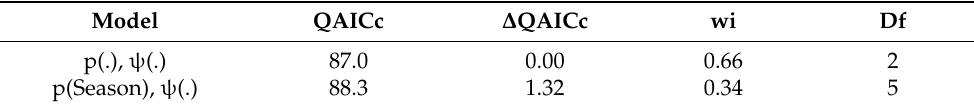
Table 3. Single-season occupancy models used in model averaging for Dipodomys heermanni. ψ is the probability a site is occupied, and p is the probability of detecting a species should it be present. Covariate included is season (spring, summer, fall, winter). Data were collected during surveys at Oceano Dunes State Vehicle Recreation Area on D. h. arenae .